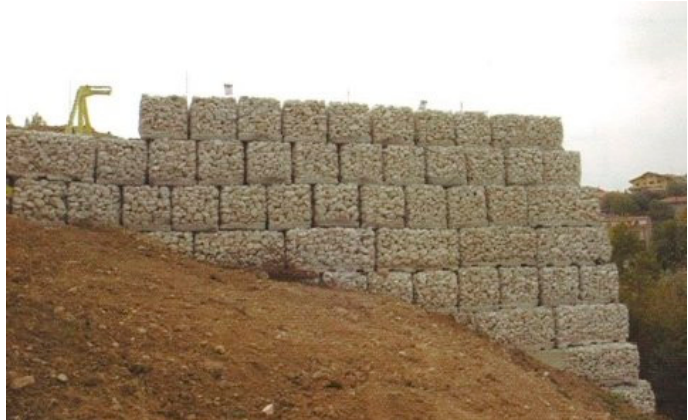
Figure 22. Metallic gabions for retaining walls and slope stabilization.